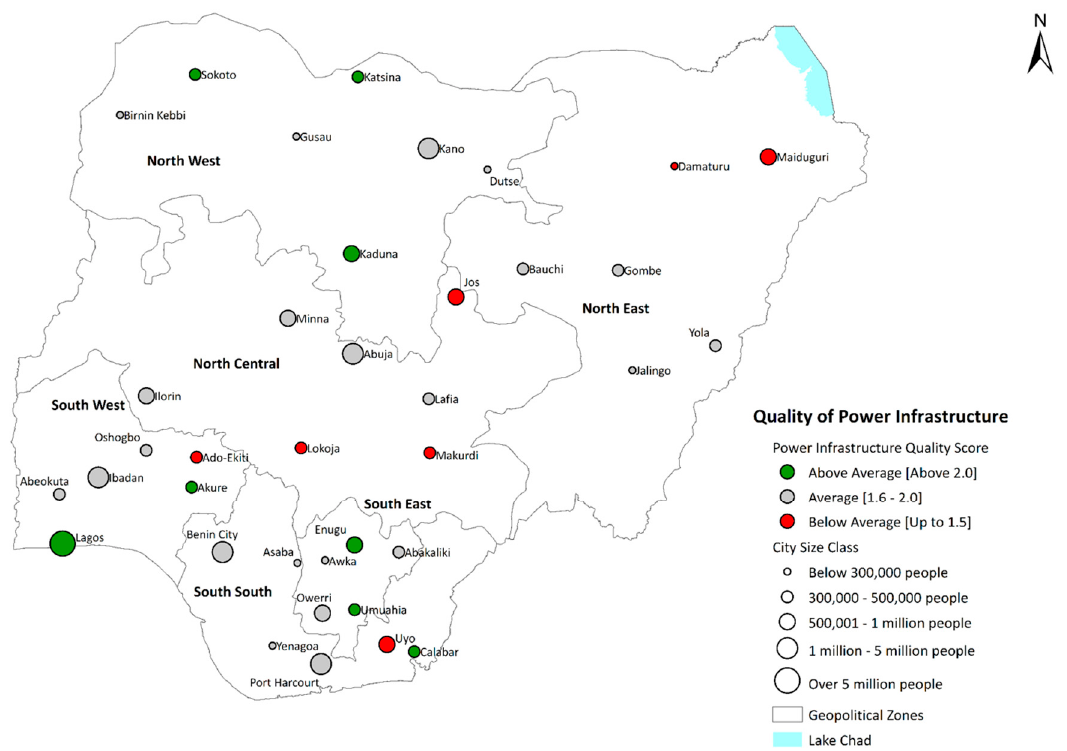
Figure 6. Quality of Power Infrastructure 2007/2009.